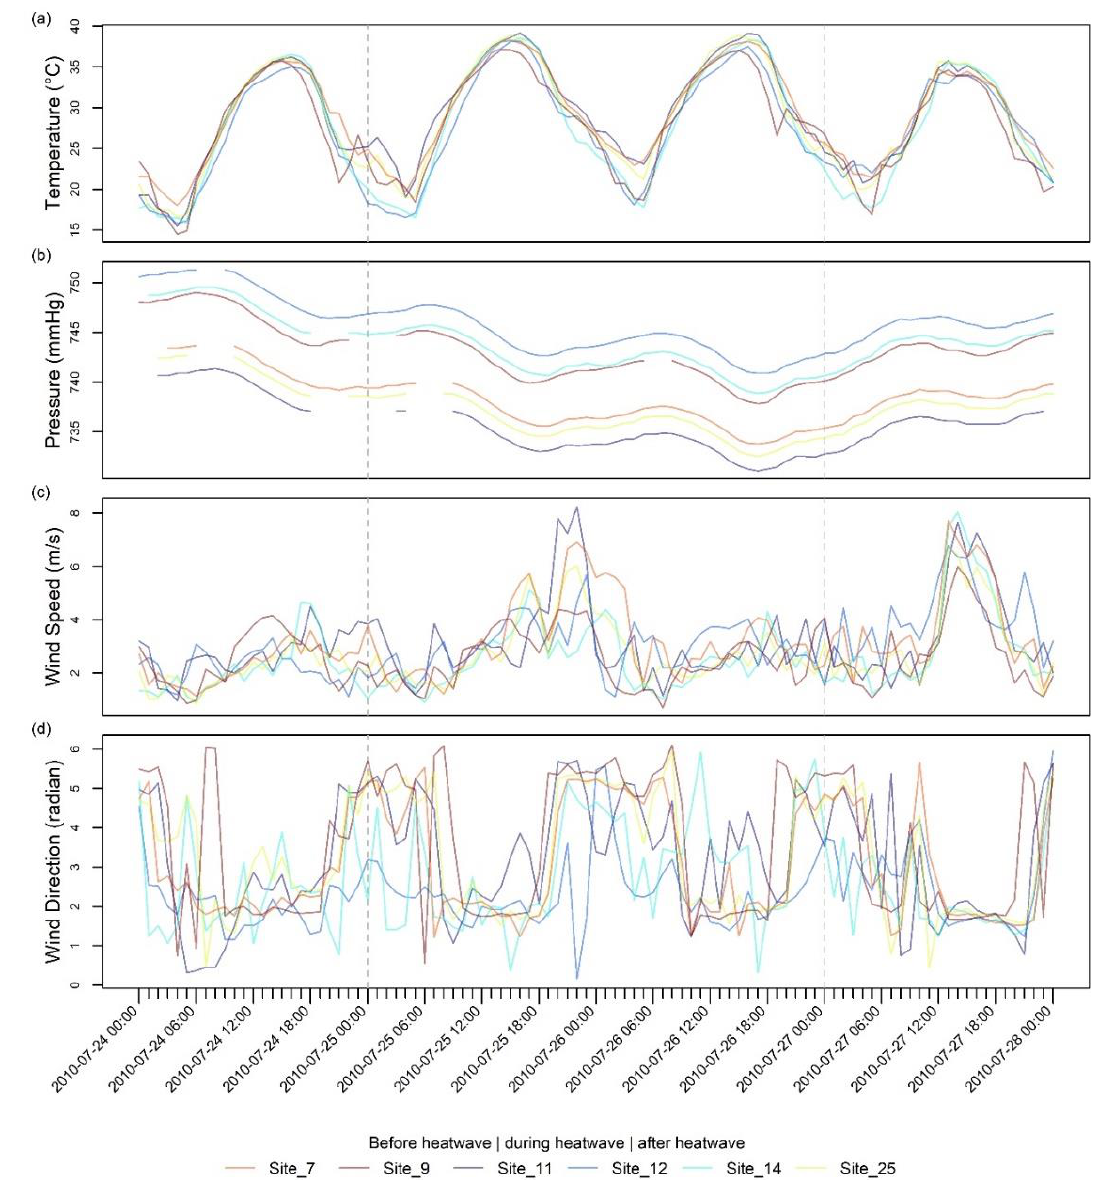
Figure 5. The time series plots of the day before, during, and after the heatwave: ( a ) temperature, ( b ) pressure, ( c ) wind speed, and ( d ) wind direction. The grey dashed line indicates when the recorded heatwave event occurs.